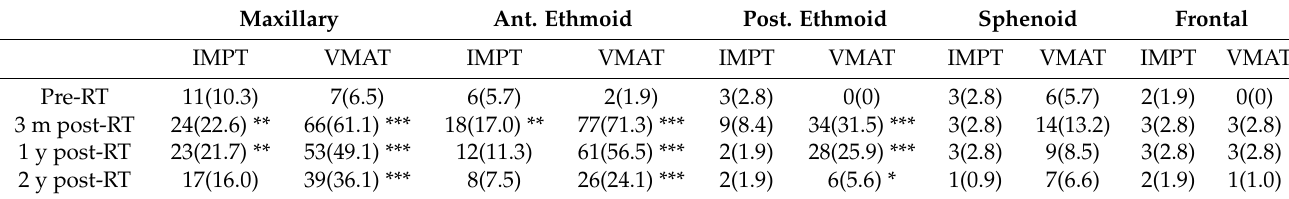
Table 3. Incidences of mucosal abnormalities in 106 sinuses of patients treated with intensity- modulated proton therapy and 108 sinuses of patients treated with volume-modulated arc